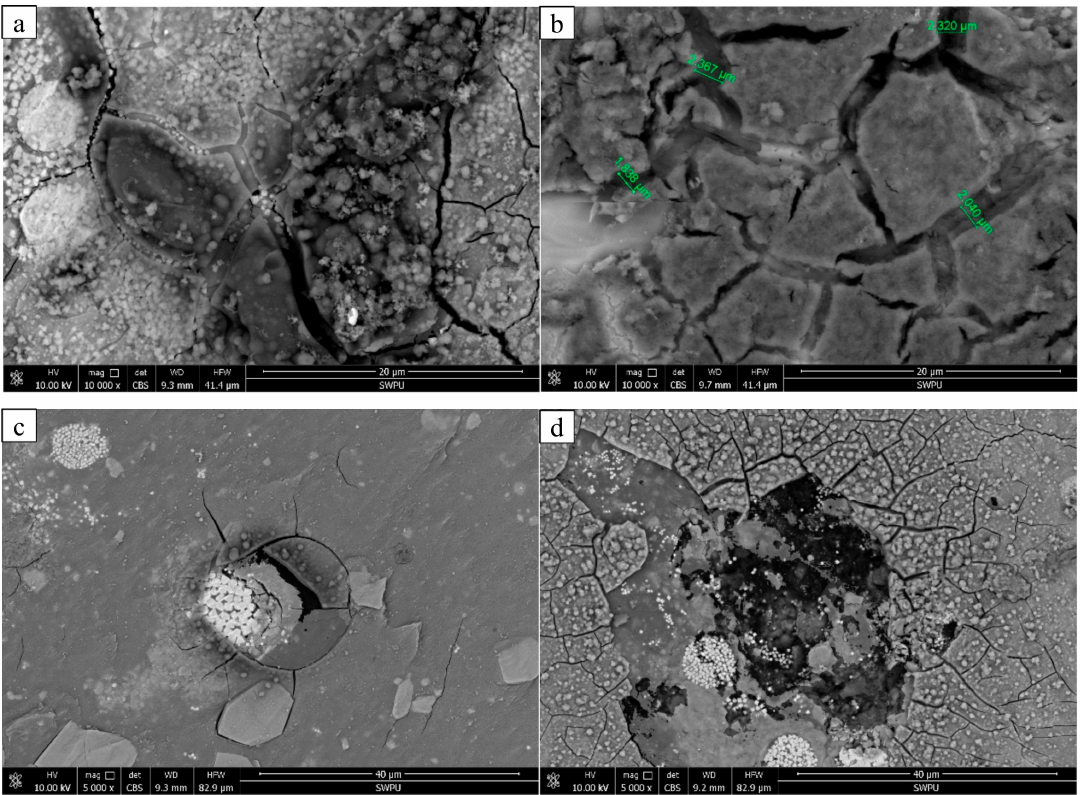
Figure 18. Scanning electron microscopy photographs after soaking in WBM-SL; ( a ) and ( b ) plugging of pores and cracks by solid particles and soil powder; ( c ) and ( d ) protective mud layer on the rock, some protective layers split or fell o ff because of the drying